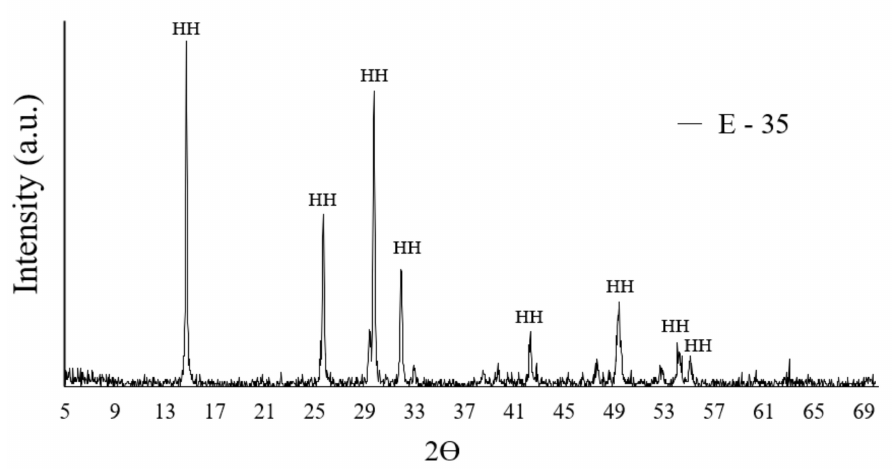
Figure 1. X-ray diffractogram of the plaster E-35 used. HH—calcium sulfate hemihydrate.